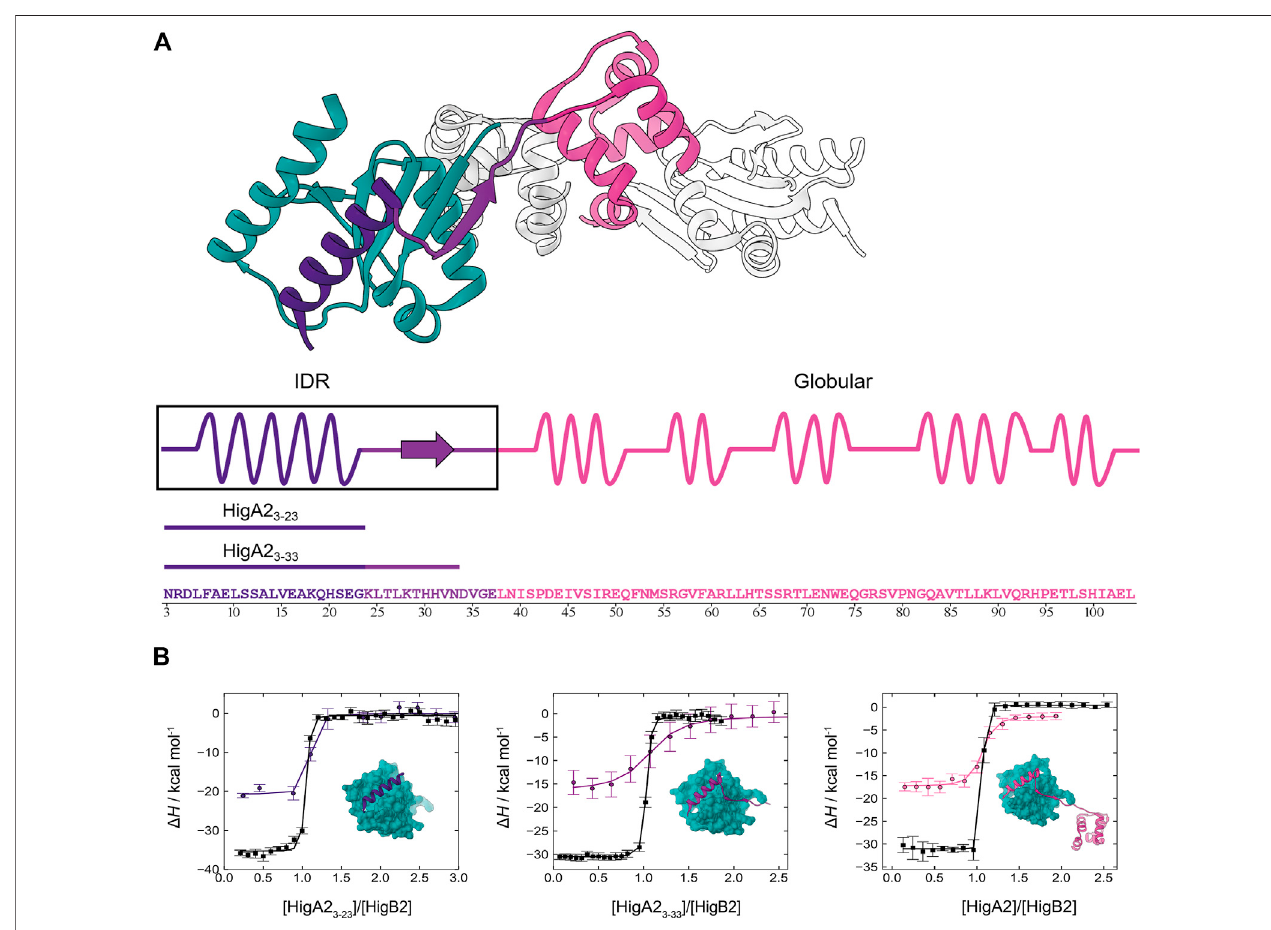
FIGURE 1 | Intrinsically disordered HigA2 binds to its globular target with picomolar af fi nity. (A) The overall structure of HigA2-HigB2 antitoxin-toxin tetramer (PDB 5JAA). Only one pair of chains (heterodimer) is colored for clarity. Globular toxin HigB2 is shown in dark cyan, while three antitoxin ’ s structural segments are shown in indigo (IDP α -helix motif), violet (IDP β -strand motif) and pink (globular domain). Underneath the sequence of HigA2 antitoxin and its truncated versions is shown in the samecolorscheme. (B) TheITCbindingisothermscorrespondingtotitrationsofdifferentHigA2segmentsintoHigB2(directtitrationinblack)orintothenanobody- HigB2 complex(competitiontitration inindigo, violet and pink). Theinsetshows theexpected fi nalproduct oftitrations and thelines correspond toglobal fi tofdirectand competition titrations.